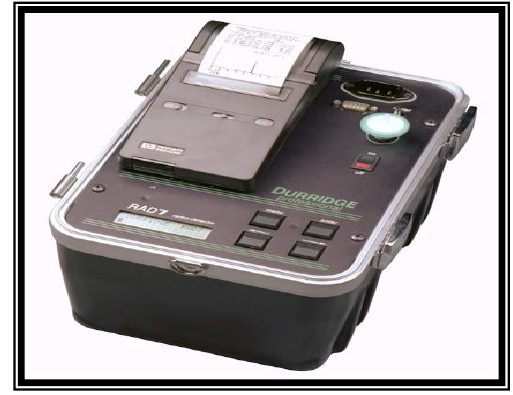
Fig. 1: The RAD-7 detector